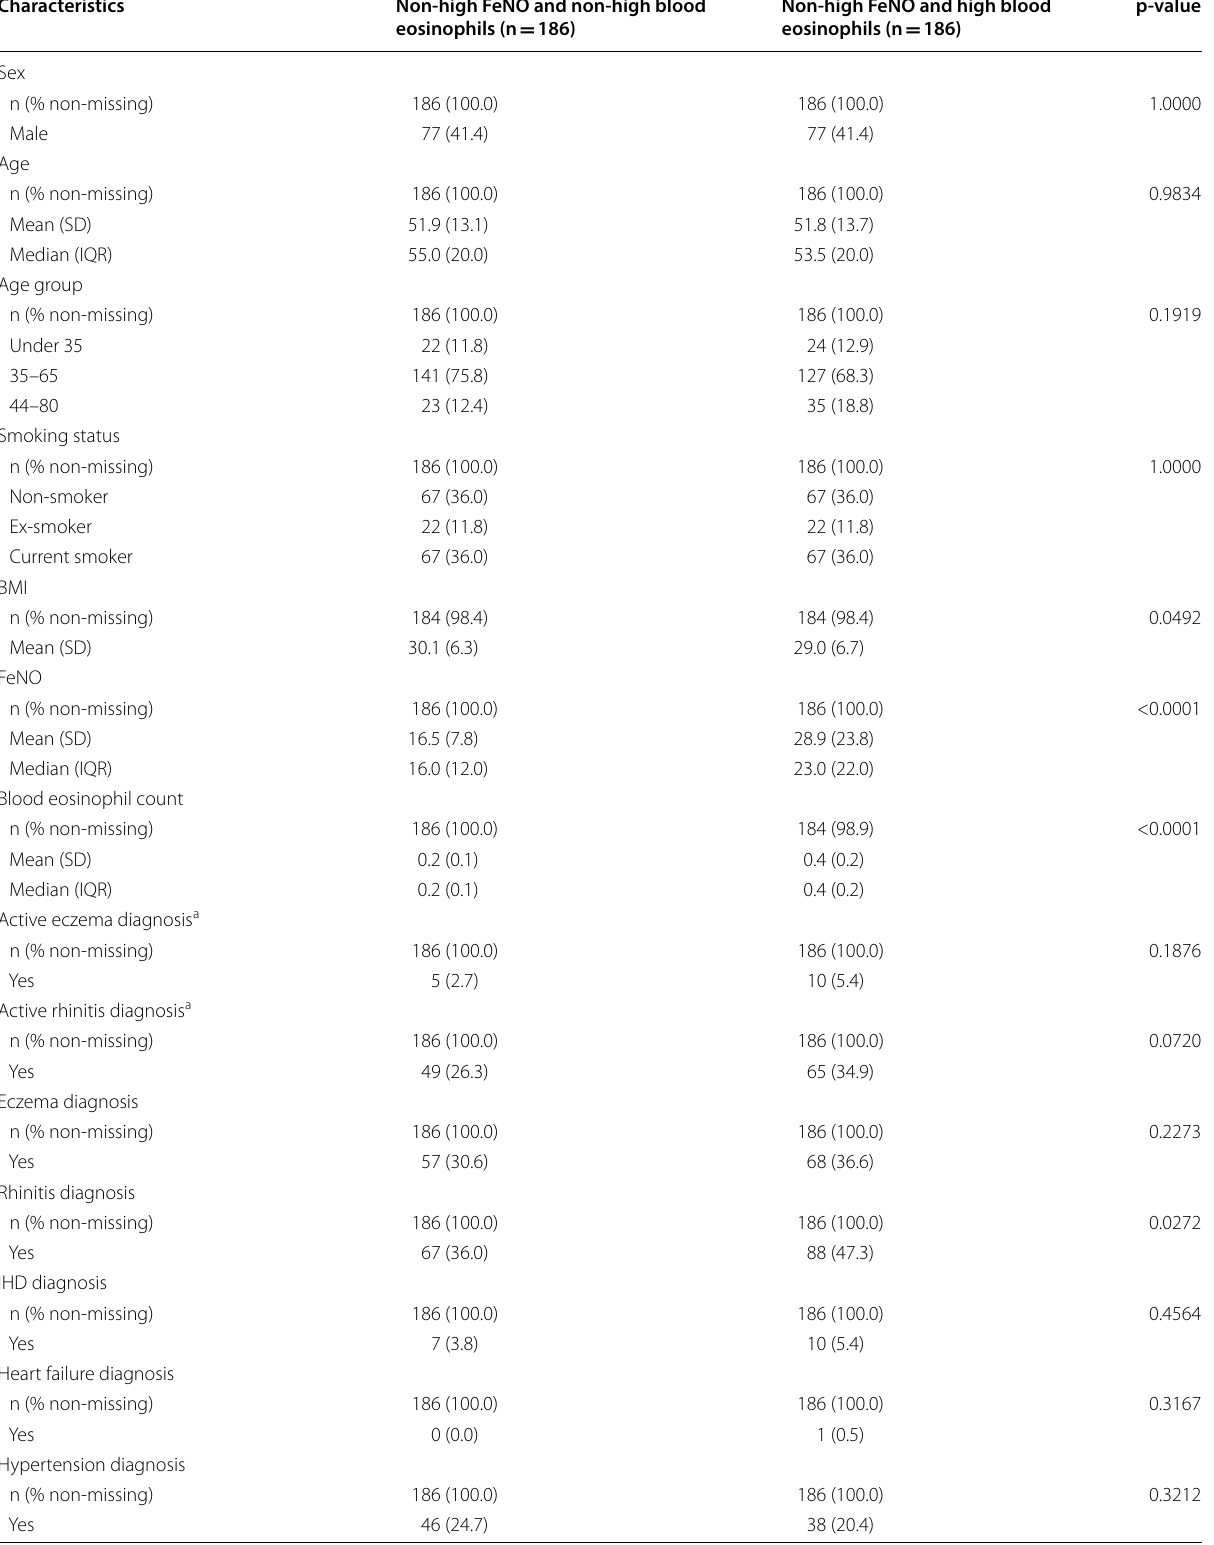
Table 3 Categorisation 2: non-high FeNO and non-high blood eosinophils vs. non-high FeNO and high blood eosinophils